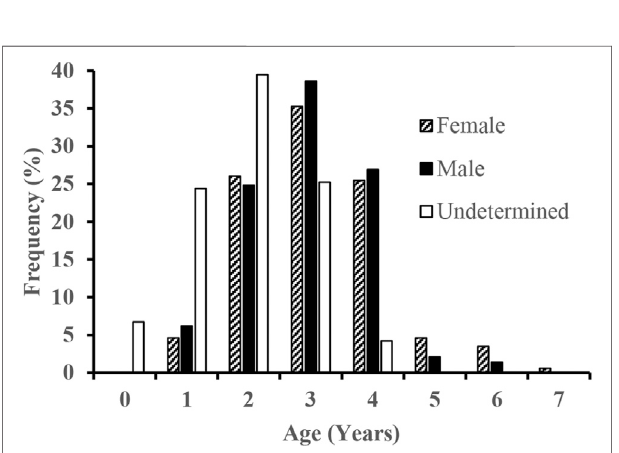
FIGURE 2 | Log-scale visual representation of the length-weight relationship of S. curriculus in the western Pearl River estuary, China.